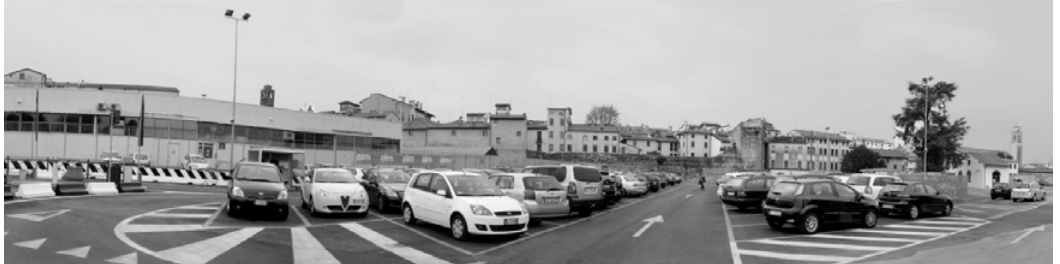
fig. 3c. View of the case study area, current state (Pozzato